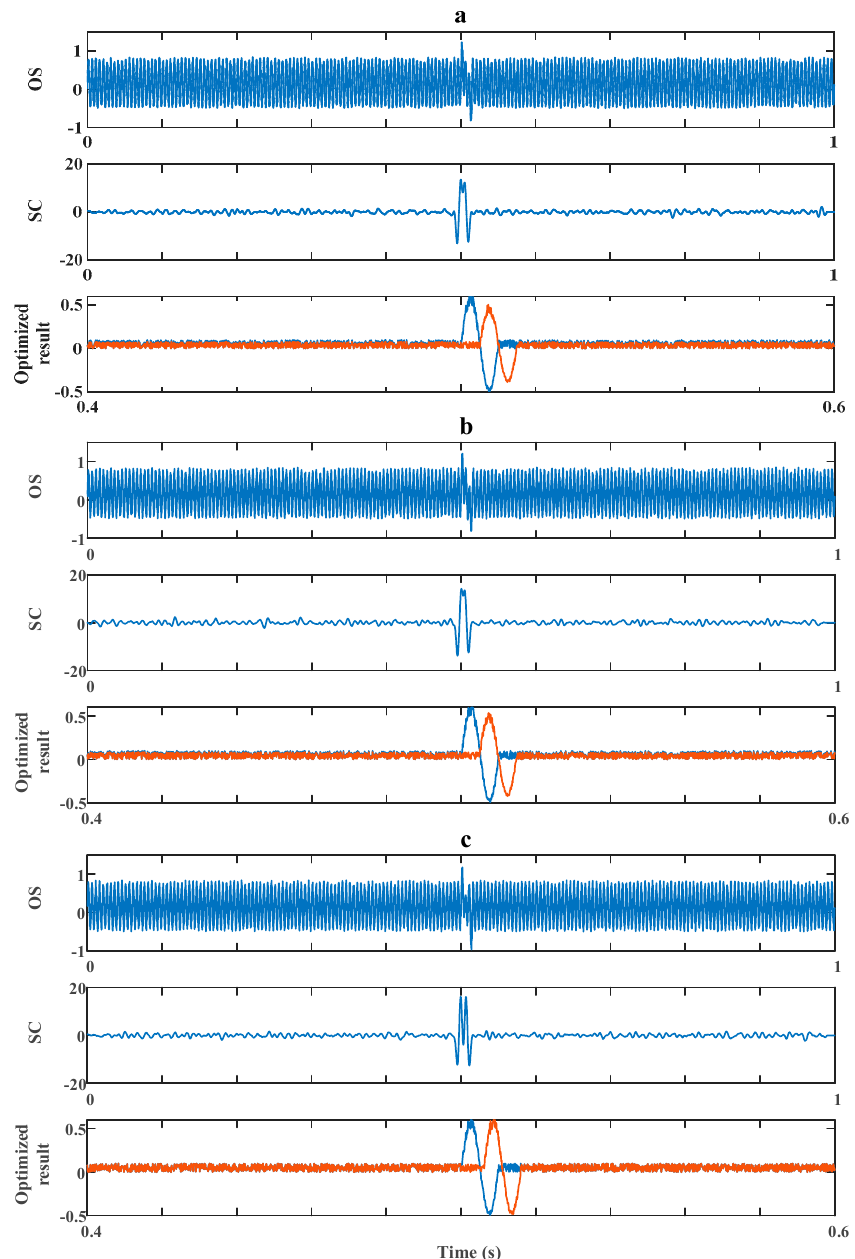
Figure 9. Method’s performance for signals of low signal-to-noise ratio ( SNR ) while k = 1. ( a ) ∆ t = 0.5 T . ( b ) ∆ t = 0.48 T . ( c ) ∆ t = 0.6 T .